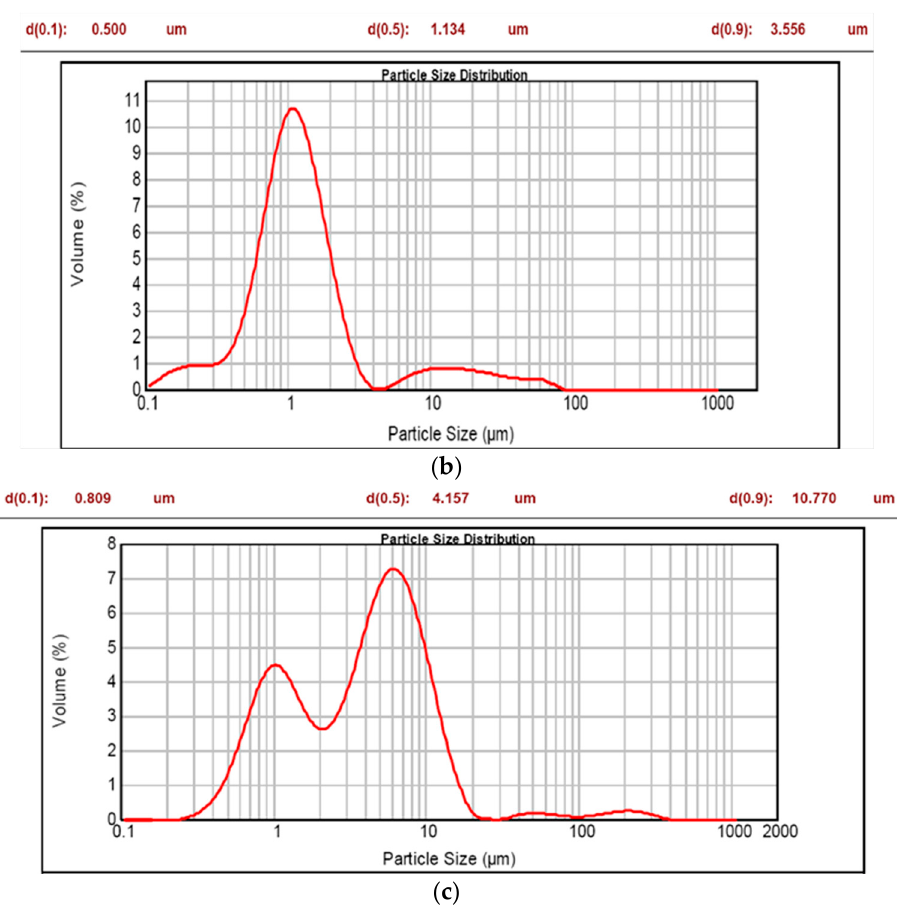
Figure 6. Particle size distribution for a 70 wt. % B35/50 for ( a ) d(0.5) s , ( b ) d(0.5) l , and ( c ) bimodal emulsion.